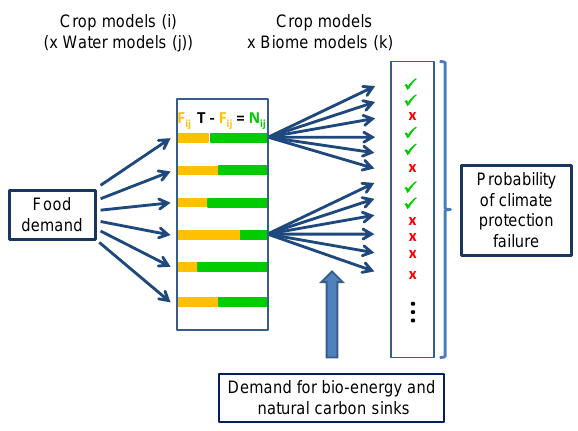
Figure 2. Implementation of the probabilistic decision framework based on multi-model impact projections. Step 1: food demand is translated into required food production area (F) based on multi- crop model simulations ( i ) (potentially combined with multiple wa- ter model simulations ( j ) to account for irrigation water constraints) under a fixed management assumption (yellow bars). T = total land area available for food or bio-energy production and conservation for natural vegetation. N = land area left for bio-energy production or natural vegetation assuming future food demand will always be fulfilled (green bars). Step 2: each pattern N ij is evaluated if it is sufficient to fulfil a pre-determined demand for natural carbon sinks and bioenergy production based on multiple crop model and biome model simulations (green tick marks show agreement and red crosses